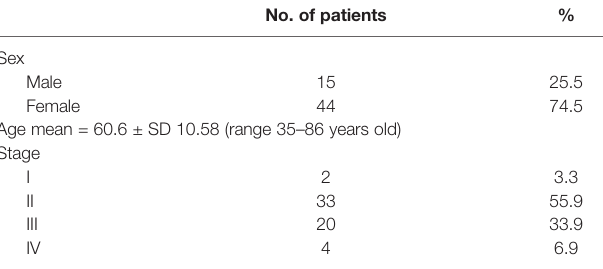
TABLE 1 | Patient characteristics ( n =